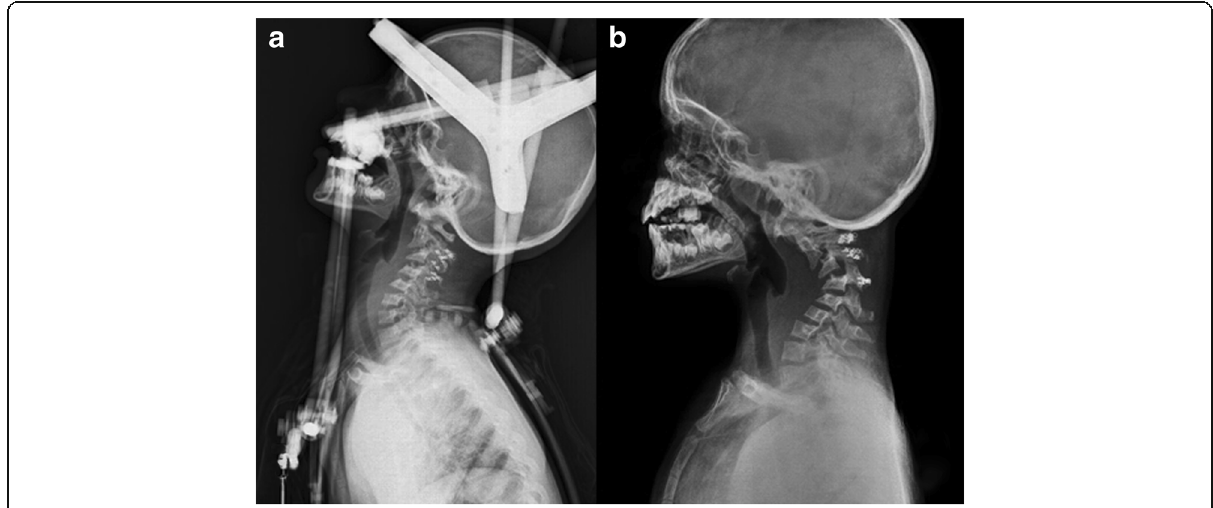
Fig. 4 a Lateral cervical spine X-ray showing correction of the deformity with Halo fixation device. b Lateral cervical spine X-ray showing reincrease of cervical kyphosis after removal of halo vest